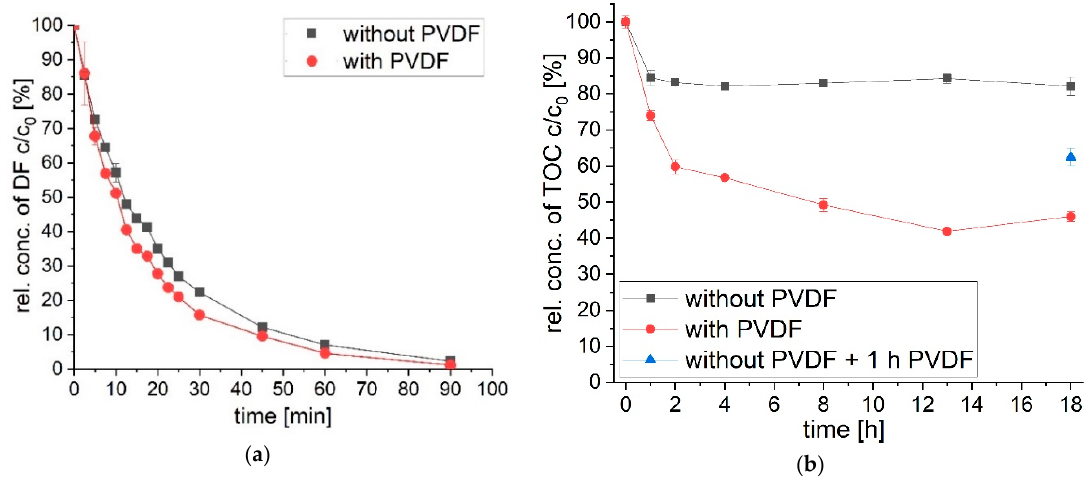
Figure 4. The transformation of diclofenac with UVA light over time with and without a PVDF is followed by analyzing the concentration decrease of diclofenac via HPLC ( a ) and by investigating the removal of organic carbon via TOC analysis ( b ). A PVDF membrane was added for 1 h (no UVA) after 18 h of UVA treatment of a diclofenac solution (blue triangle in ( b )).